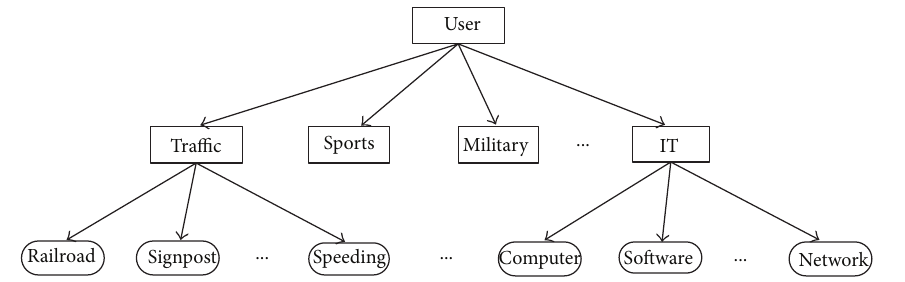
Figure 1: The logic structure of user interest model.